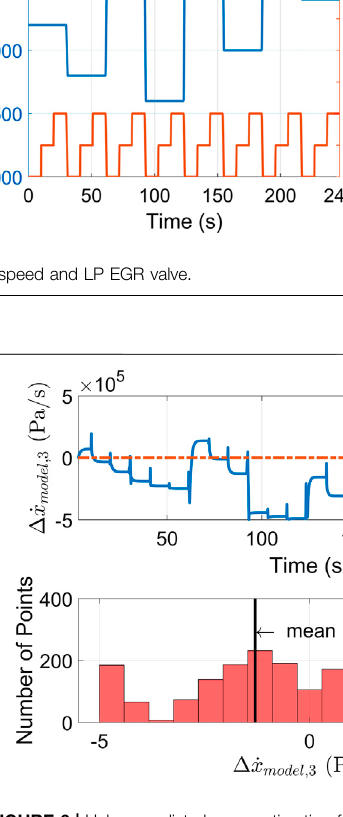
FIGURE 4 | Engine operation conditions: engine IMEP.